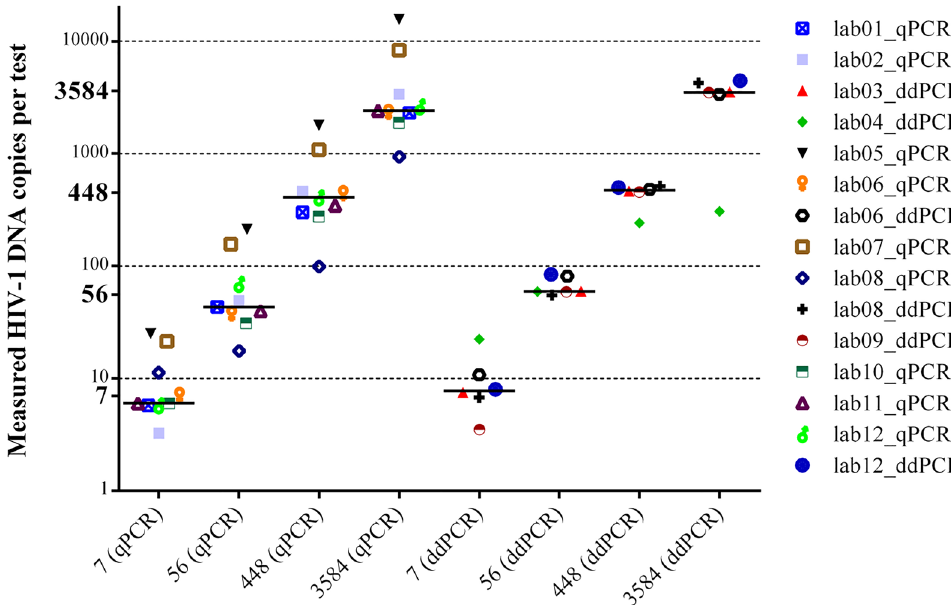
Figure 2. Expected and measured HIV-1 DNA copy values with the reference standard dilution series, stratified for qPCR and ddPCR. Bars indicate median values. Graphic elaboration was realized using the GraphPad Prism